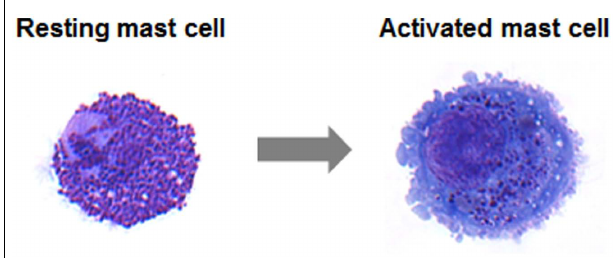
FIGURE 1 | May–Grünwald/Giemsa stain of a resting human intestinal mast cell and a mast cell following activation induced degranulation. Note the increase in size and loss of granule